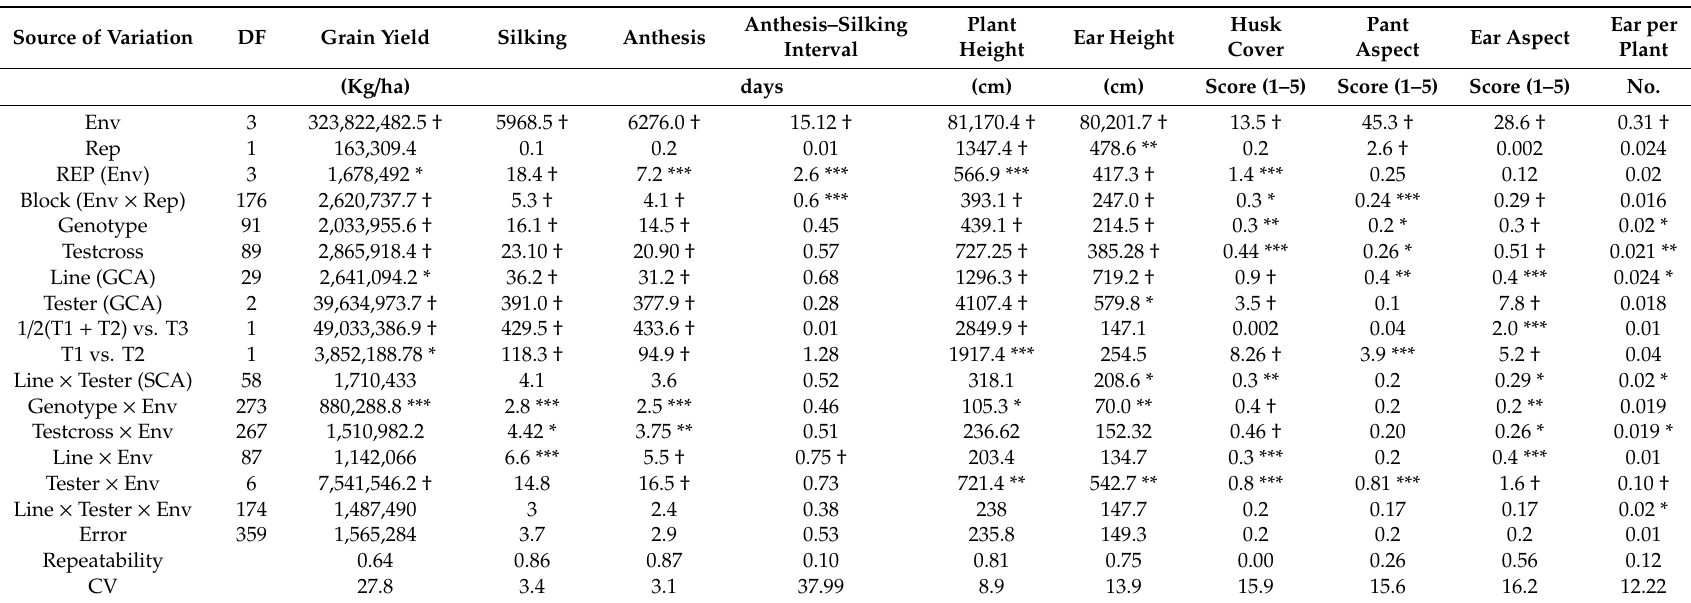
Table 2. Mean squares for grain yield and other traits of testcrosses of yellow maize inbred lines under the Striga -non-infested condition in four environments. Source of Variation